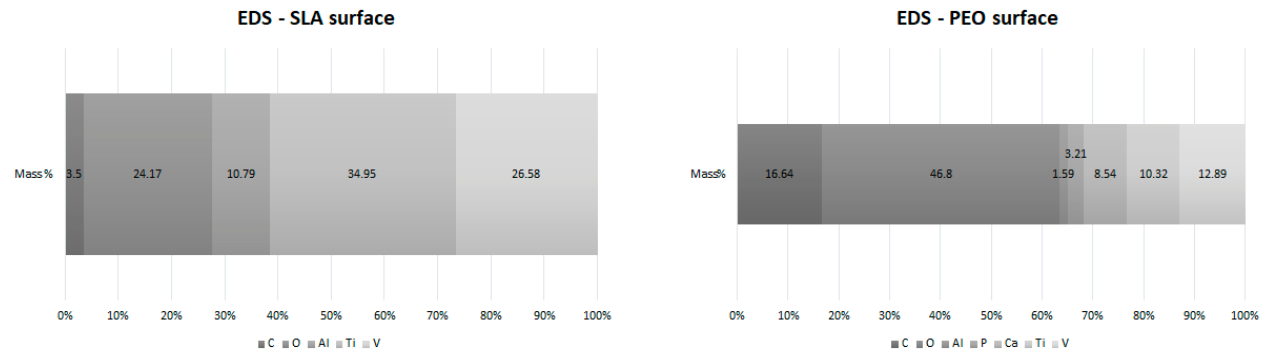
Figure 2. Energy dispersive spectroscopy of Ti6Al4V alloy (percentage by weight—wt%) for SLA surface and PEO surface.